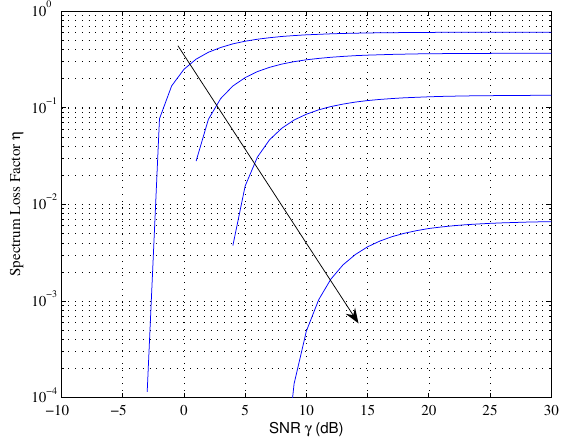
Figure 2. The reliability-oriented scheme for NCoS. k = N Along the direction of the arrow, η